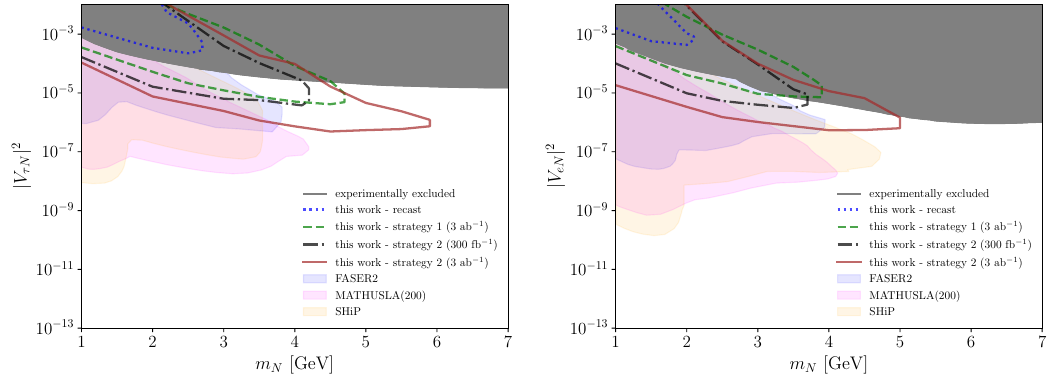
Figure 2 . Projected sensitivity of the different proposed search strategies with a displaced shower signature in the CMS muon system. The minimal HNL scenario is considered with mixings in the τ and electron sectors, shown in the left and right panel,